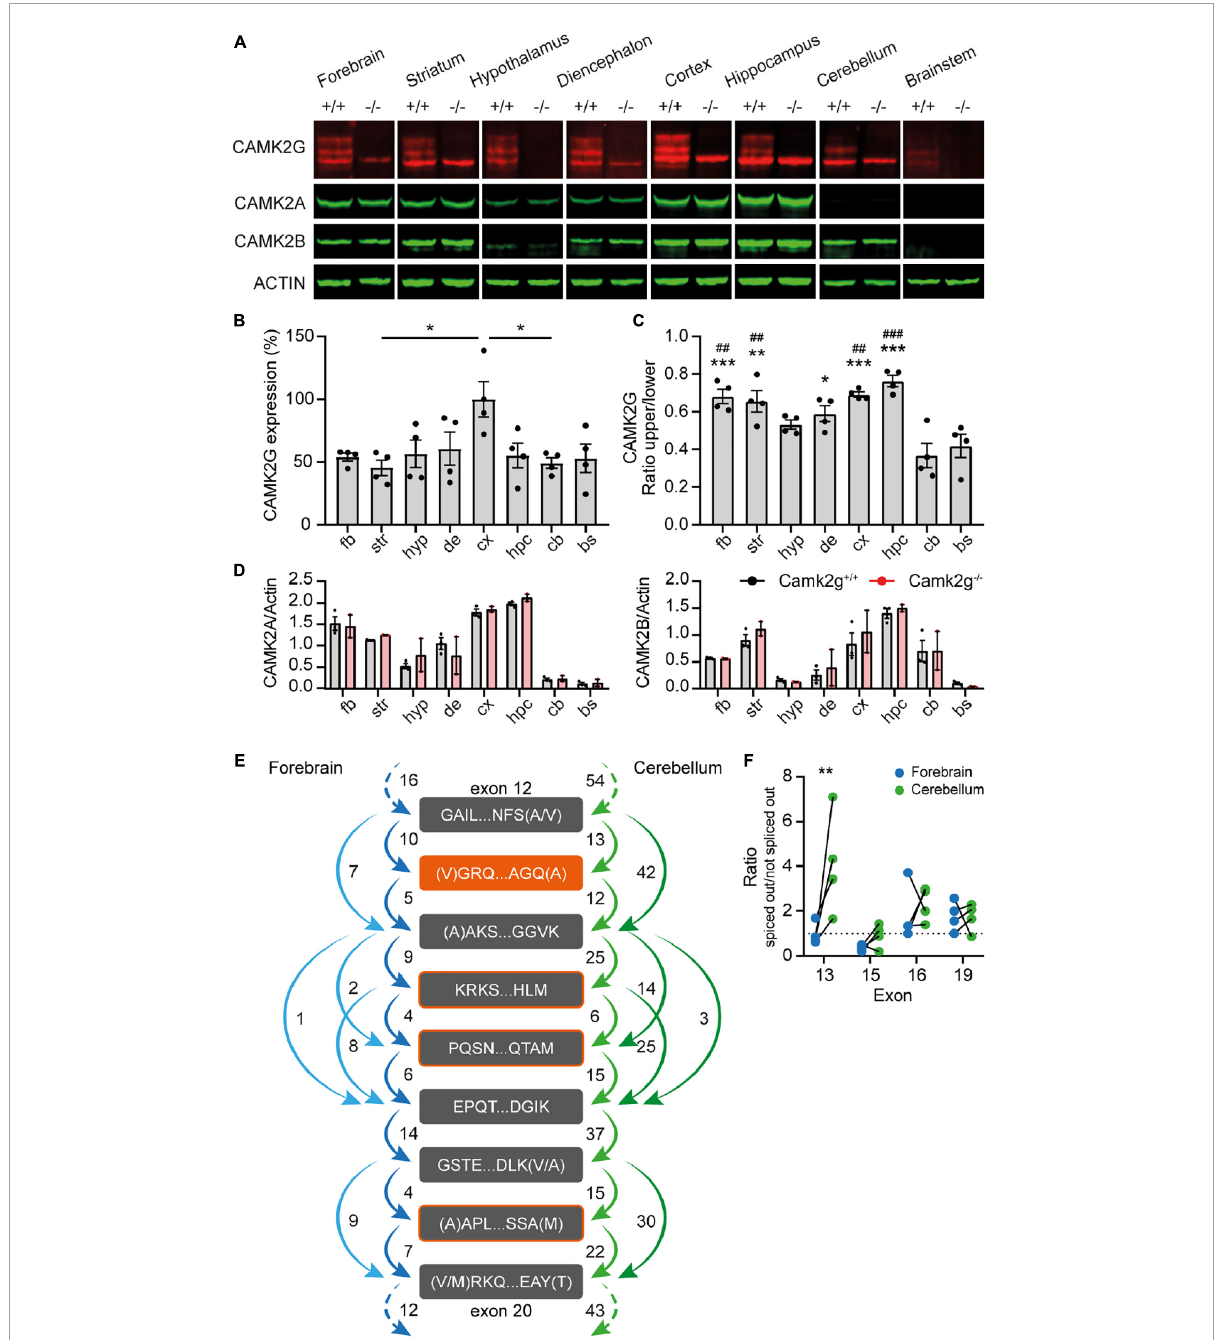
FIGURE1 CAMK2G expression profile in the brain. (A) Immunoblots of different isolated brain regions in Camk2g wild type (+/+) and knockout ( − / − ) mice probed with antibodies against CAMK2G, CAMK2A, CAMK2B, and ACTIN. Note the triple band of CAMK2G, of which 2 are absent in Camk2g − / − mice. (B) Quantification of CAMK2G expression, normalized to values in the cortex. fb, forebrain; str, striatum; hyp, hypothalamus; de, diencephalon; cx, cortex; hpc, hippocampus; cb, cerebellum; bs, brainstem [one-way ANOVA with Bonferroni’s post hoc analysis, F ( 7 , 24 ) = 2.98, p = 0.021; fb vs. str p > 0.999, fb vs. hyp p > 0.999, fb vs. bg p > 0.999, fb vs. cx p = 0.088, fb vs. hpc p > 0.999, fb vs. cb p > 0.999, fb vs. bs p > 0.999, str vs. hyp p > 0.999, str vs. bg p > 0.999, str vs. cx p = 0.019, str vs. hpc p > 0.999, str vs. cb p > 0.999, str vs. bs p > 0.999, hyp vs. bg p > 0.999, hyp vs. cx p = 0.134, hyp vs. hpc p > 0.999, hyp vs. cb p > 0.999, hyp vs. bs p > 0.999, bg vs. cx p = 0.272, bg vs. hpc p > 0.999, bg vs. cb p > 0.999, bg vs. bs p > 0.999, cx vs. hpc p = 0.109, cx vs. cb p = 0.037, cx vs. bs p = 0.073, hpc vs. cb p > 0.999, hpc vs. bs p > 0.999, cb vs. bs p > 0.999; n = 4]. (C) Ratio of the specific CAMK2G bands. The lower band shows higher expression levels throughout the brain, but